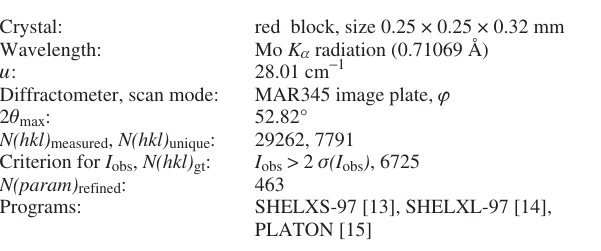
Table 1. Data collection and